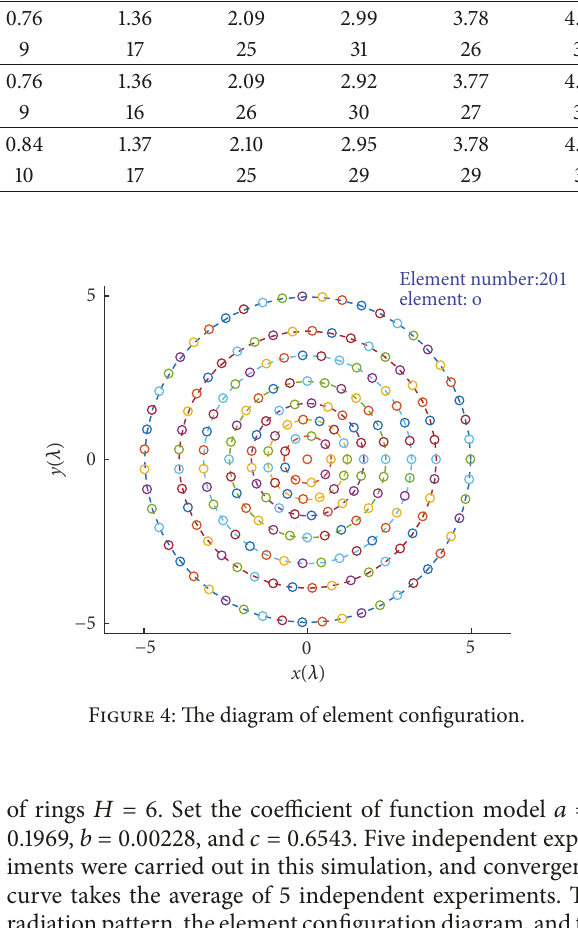
Table 4: Comparing the optimal result of 𝑁 = 142 and 𝐻 = 6 with [21, 22]. Function model algorithm using MGA (FMAMGA), element number ( 𝑁 ), ring radii ( 𝑟 𝑛 (𝜆) ), and element number in the rings ( 𝑁 𝑛 ). method